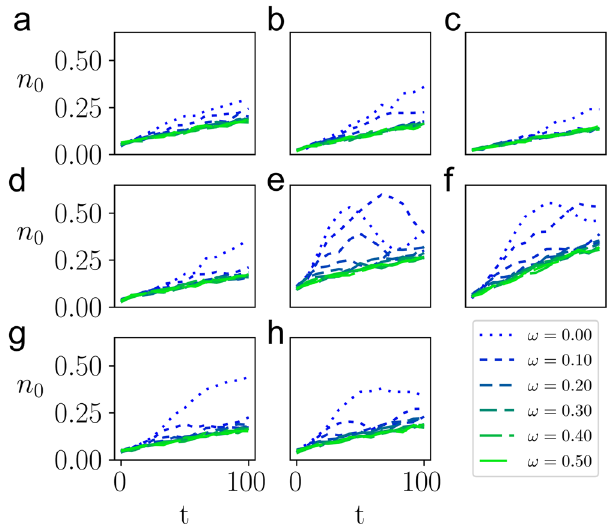
Fig. 3 Demonstration of simulated time evolution for different devices and qubits. Ground-state populations n 0 obtained from simulated time evolution with different devices and qubits (indicated by the i th qubit Q i ). Systems were initialized in the 1 j i state and evolved for time t with Hamiltonian H = ωσ z . The frequency is given by ω , time step τ ¼ 1 de fi ned in Eq. (2). a Q2, ibmq_belem. b – d Q0, Q2, Q4, ibmq_bogota. e Q0, ibmq_armonk. f – h Q0, Q2, Q4, ibmq_casablanca. Legend shows frequencies ranging from ω = 0 (blue, shortest dashes) to ω = 0.5 (green, longest